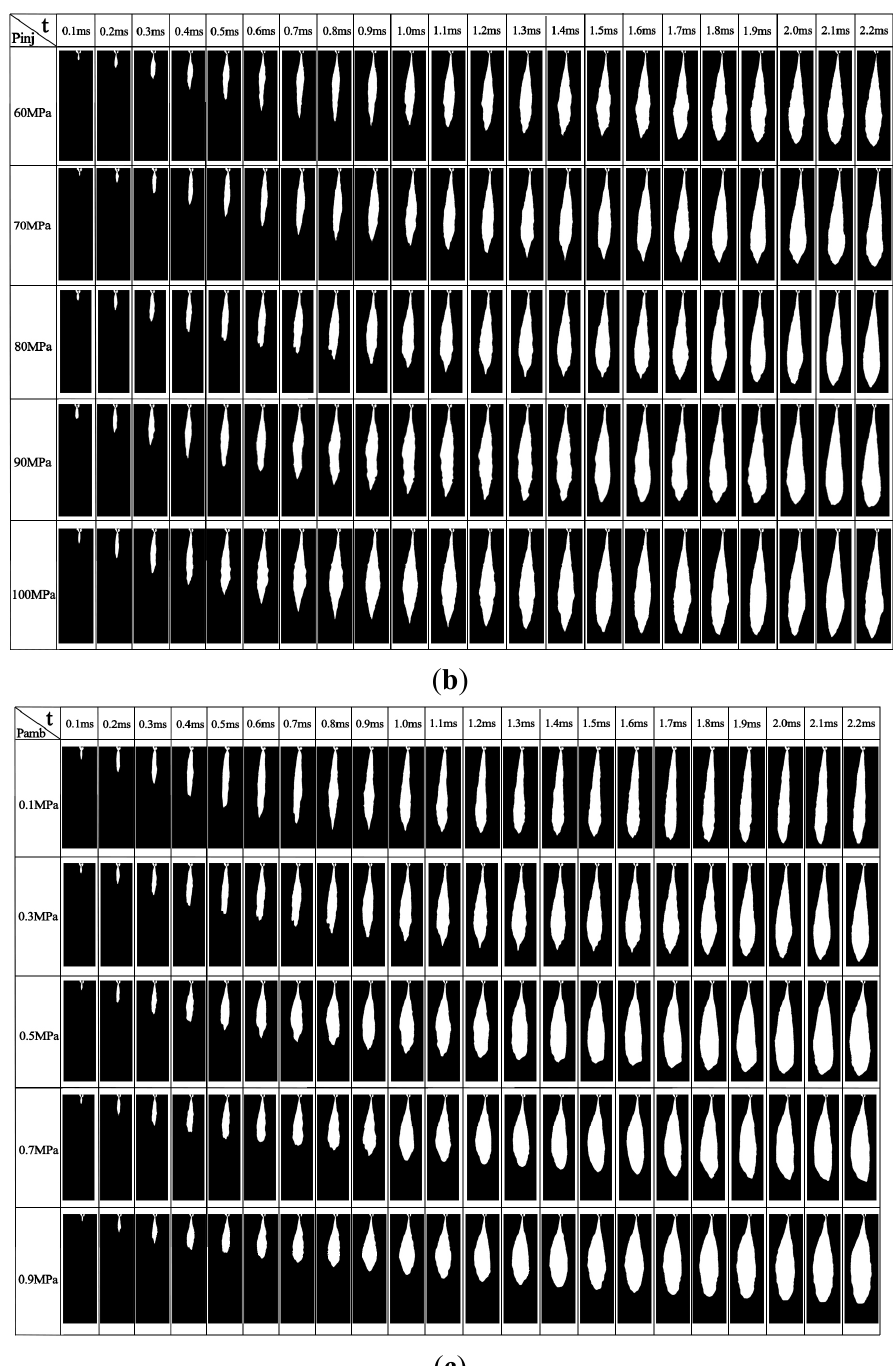
Figure 7. Spray evolution processes of the fuels after SOI for all conditions. ( a ) Pamb = 0.3 MPa, Pinj = 80 MPa; ( b ) Fuel: BD80, Pamb = 0.3 MPa; ( c ) Fuel: BD80, Pinj = 80 MPa; t , Time after start of injection